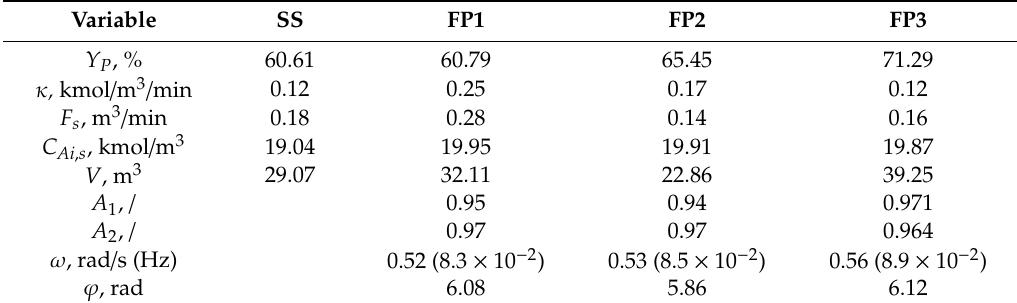
Table 3. Optimal product yield (BI1), reactor volumetric capacity (BI2 / CI), and the corresponding optimized values for Example 1 (CSTR) for points SS, FP1, FP2, and FP3 in Figure 4b. Variable